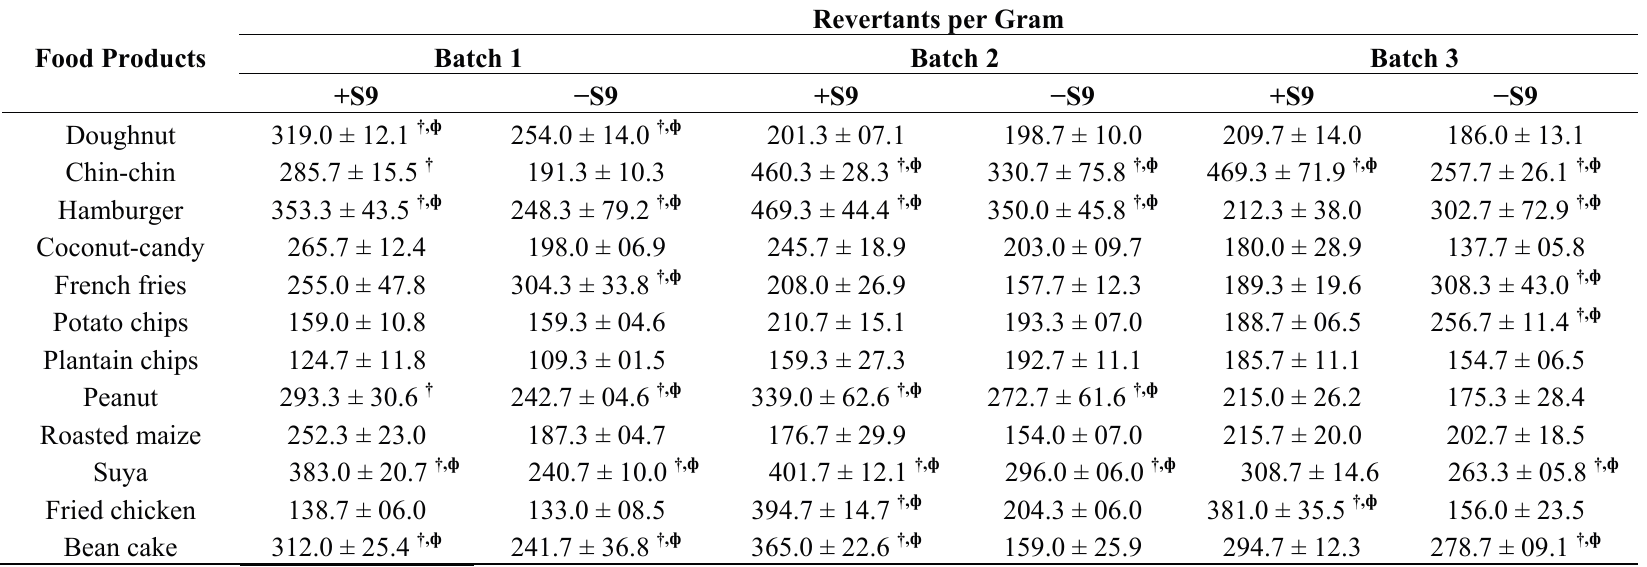
Table 2. Number of revertants generated by the highest concentrations (1.0 per g of food sample) of food extracts on Salmonella TA 100 (mean ± SD) in the standard plate incorporation